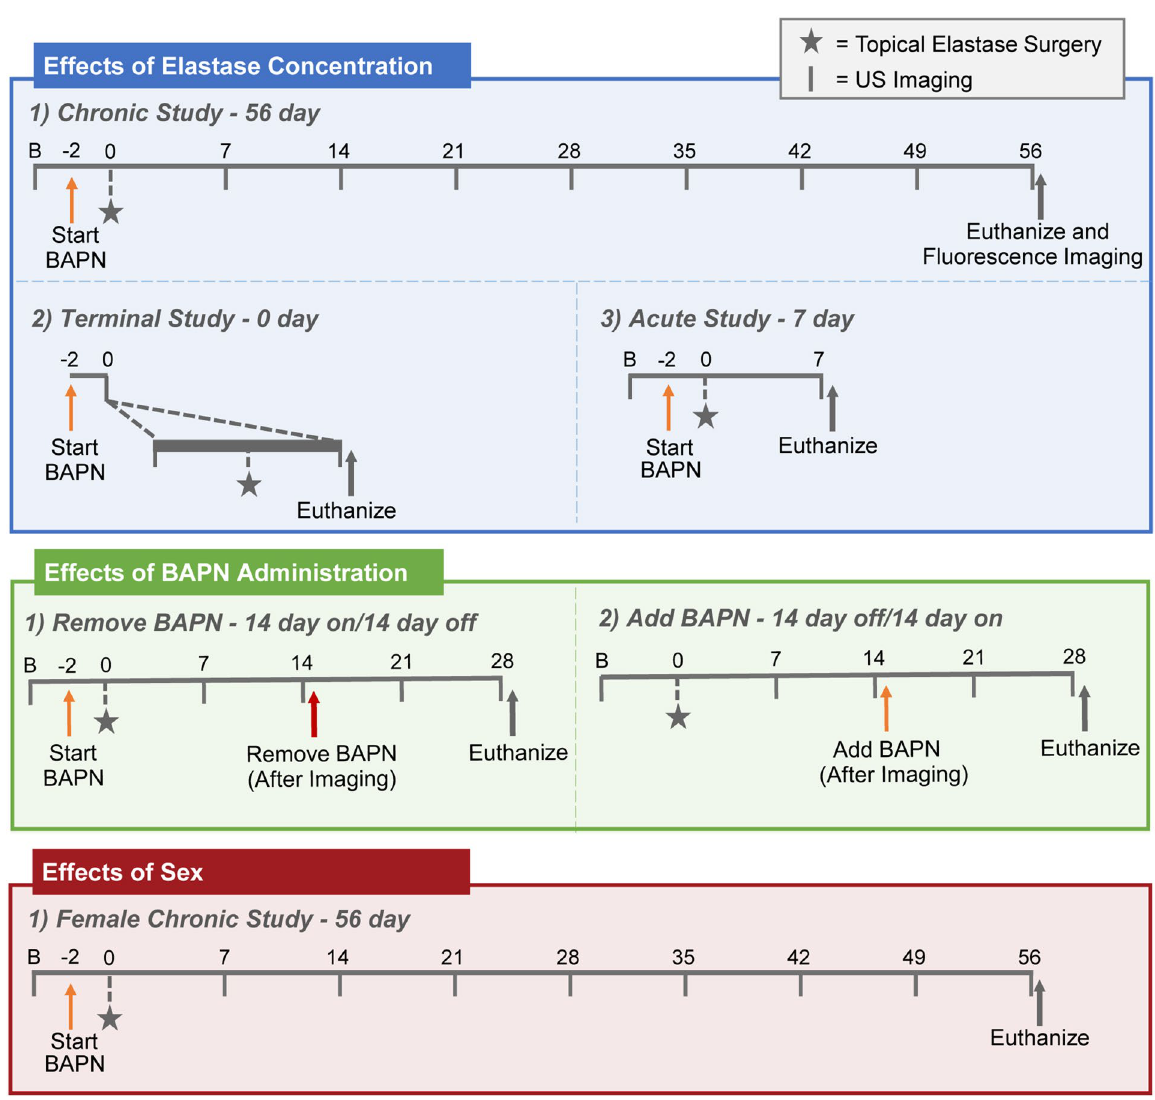
Figure 1. Experimental overview. Schematic depicts the timelines of BAPN administration, elastase surgery, ultrasound imaging, fluorescence imaging, and euthanasia for each